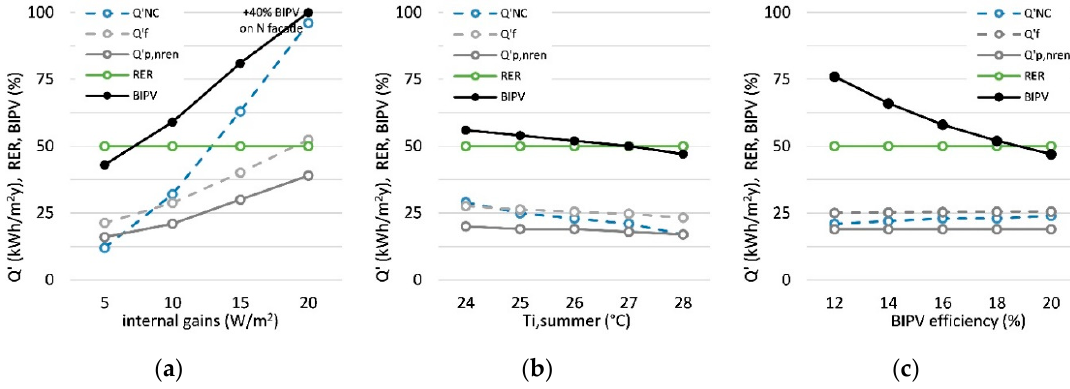
Figure 9. Parametric study of energy e ffi ciency and nZEB indicators for Type II (all-glass) building in Barcelona according to internal gains ( a ), indoor air temperature set-point ( b ), and reference e ffi ciency of BIPV ( c